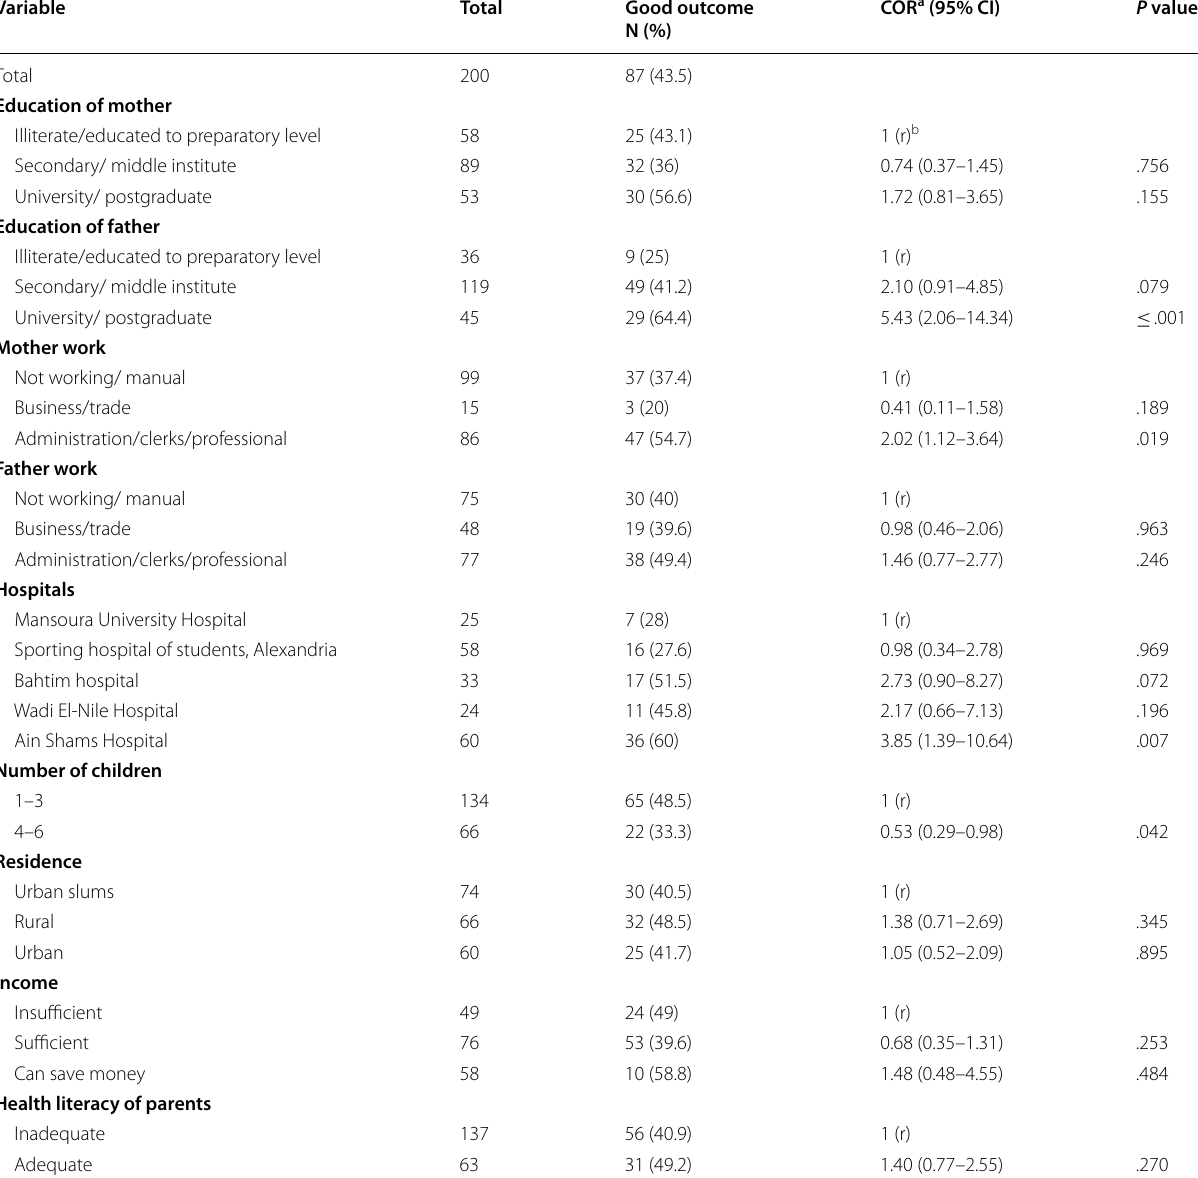
COR a Crude Odds ratio, ( r ) b